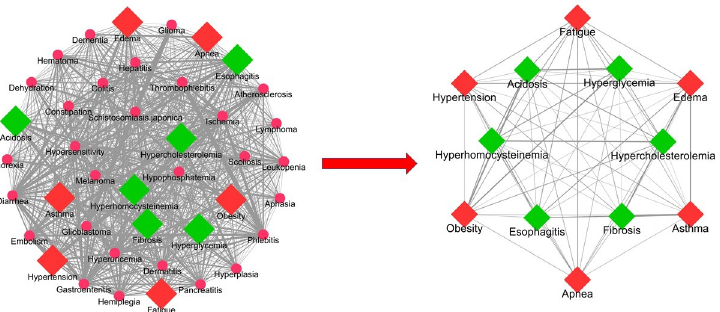
Fig 6. The left-hand side is the DSN of high altitude marked with six bottleneck diseases (square, red colour) and six community diseases (square, green colour). The overall semantic similarity (SS) average score of the DSN is 0.14188. The right-hand side is core DSN network of 12 diseases (six bottleneck and six community diseases). The overall semantic similarity score of the core DSN is 0.19624 and named as “highly comorbid diseases of high altitude”.